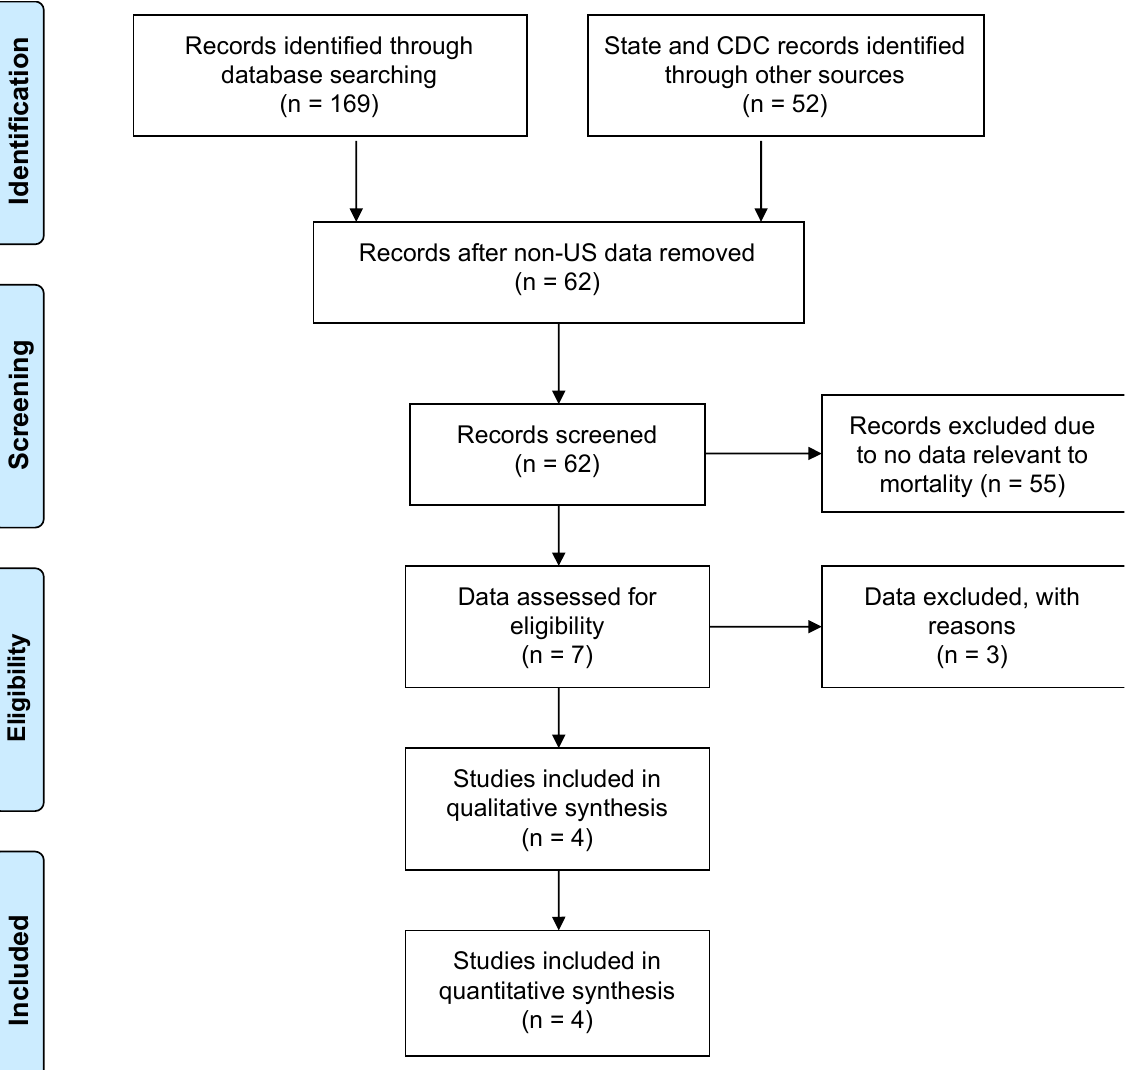
Figure 1. A flow diagram of this study, originally accessed on June 2020. The PRISMA template for researchers [5] was modified and used.